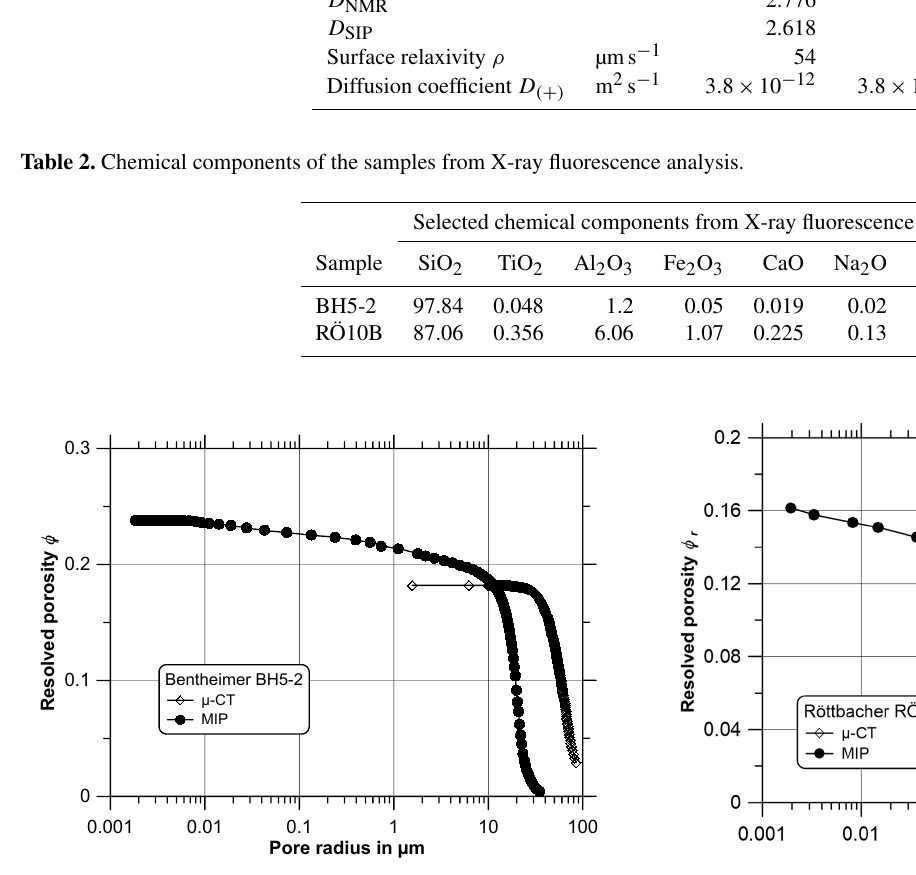
Figure 4. The recognized porosity and pore size range of Röt- tbacher sandstone sample RÖ10B. The maximum porosity recog- nized by MIP is 0.166 and the maximum porosity recognized by µ -CT is